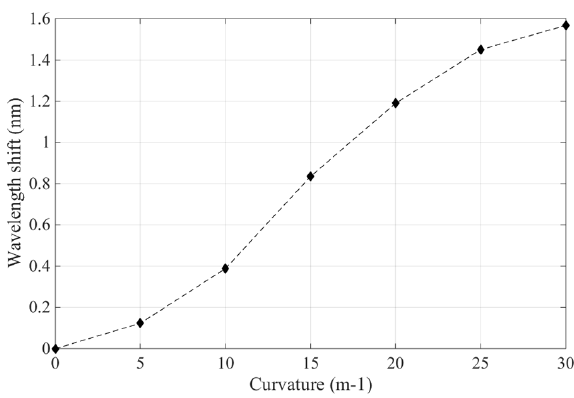
Figure 10. The wavelength shift of FBG sensor in a soft actuator.